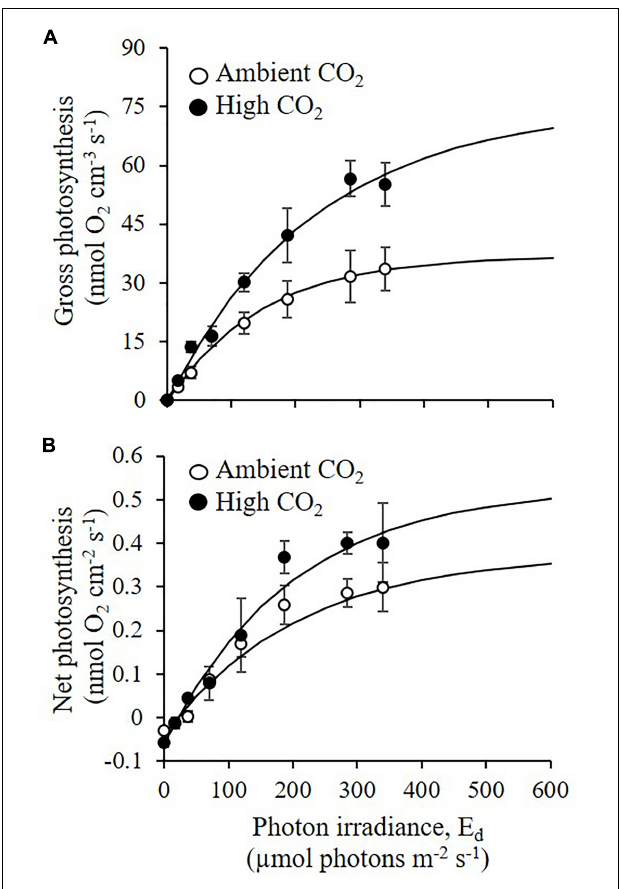
FIGURE 3 | Effects of elevated CO 2 on net and gross photosynthesis of CCA recruits. (A) Gross photosynthesis (nmol O 2 cm − 3 s − 1 ), and (B) net photosynthesis (nmol O 2 cm − 2 s − 1 ) were measured under ambient CO 2 (CO 2 between 400.8 and 448.1 µ atm, pH 8.0–8.03) and high CO 2 (CO 2 between 998.9 and 1070.6 µ atm, pH 7.67–7.70) conditions, for a range of incident downwelling photon irradiance regimes (E d : µ mol photons m − 2 s − 1 ). Symbols with error bars represent means ± SE ( n = 3 for ambient CO 2 and n = 2 for High CO 2 ; biological replicates). Solid lines represent curve